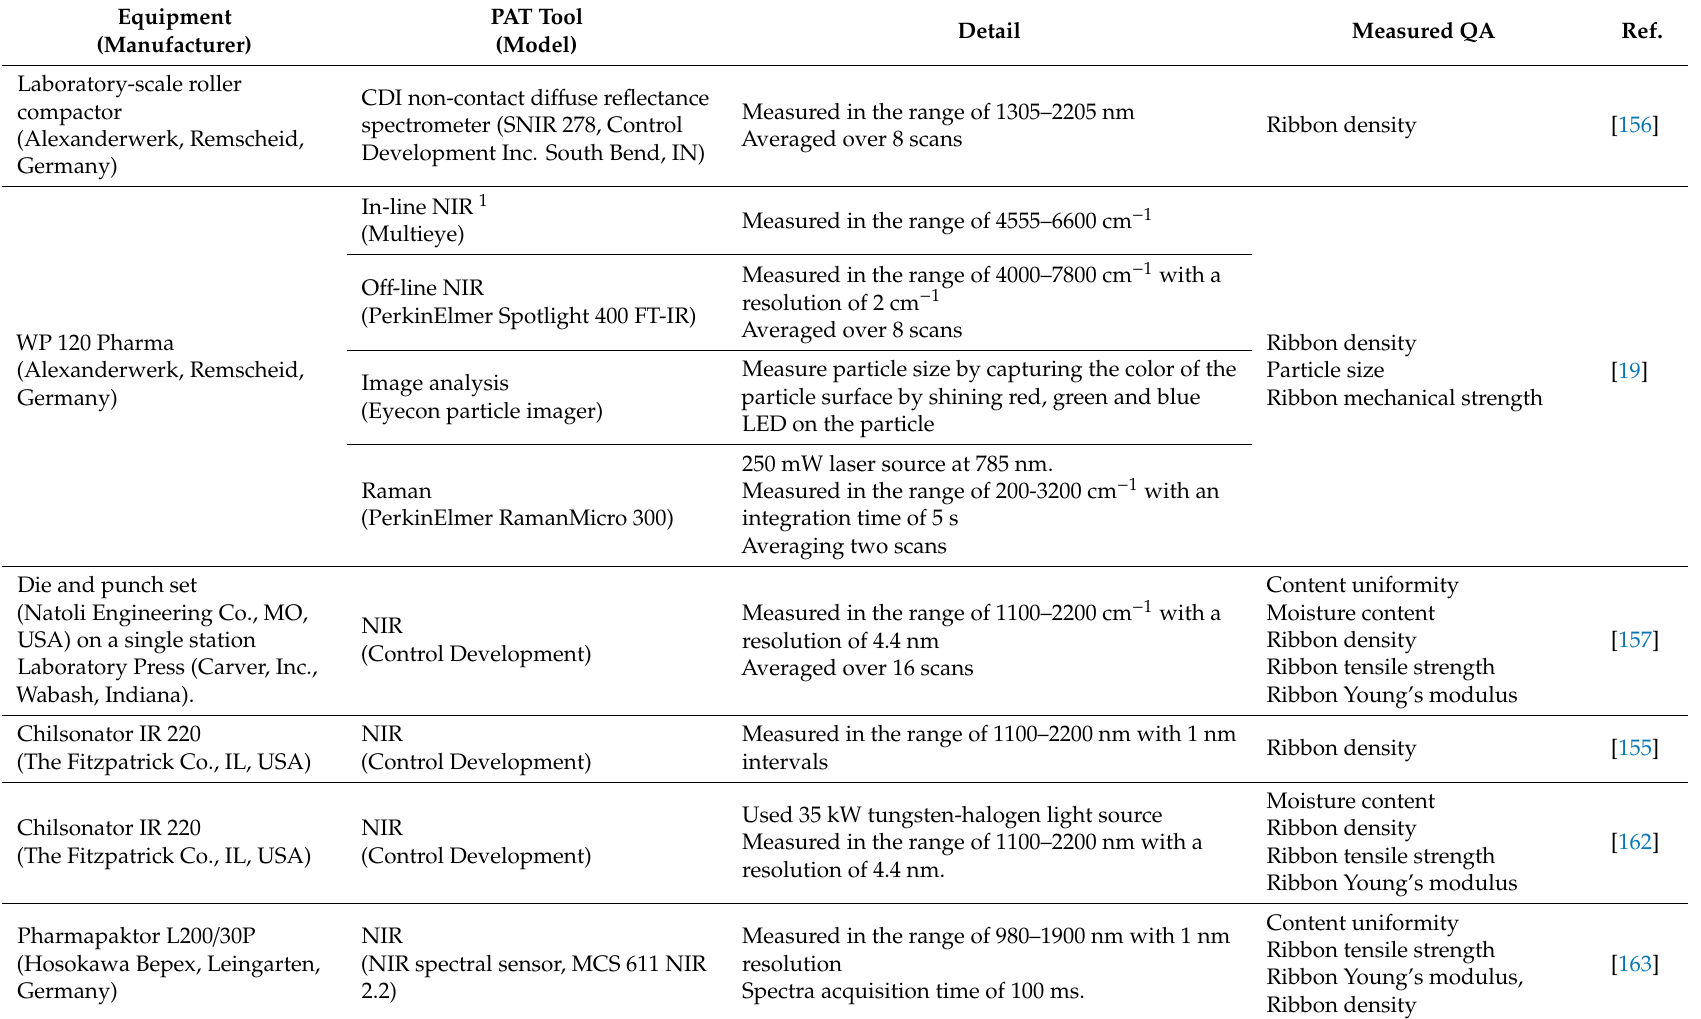
Table 7. Summary of PAT-based modeling method applied in dry granulation